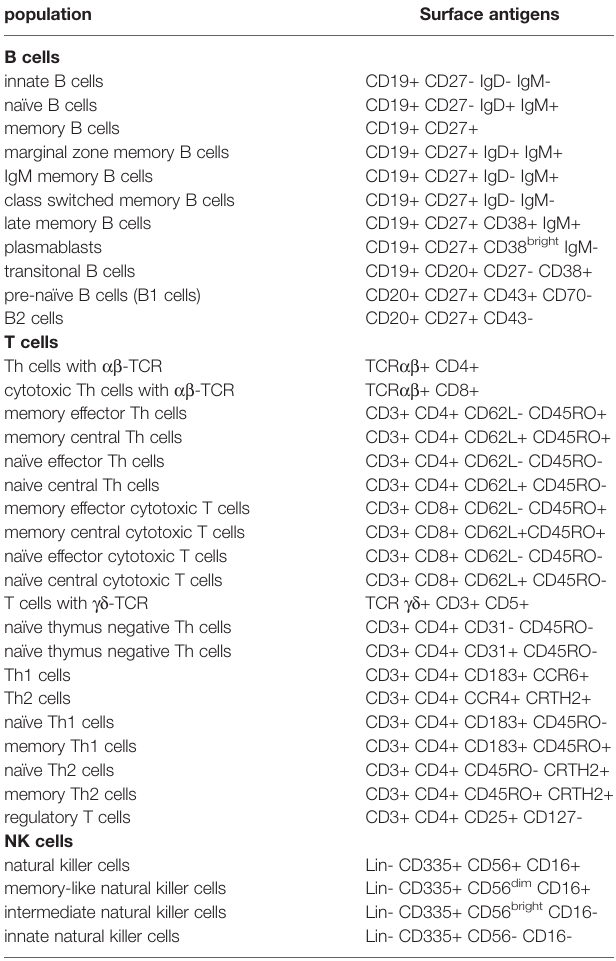
TABLE 6 | Leukocyte subsets.